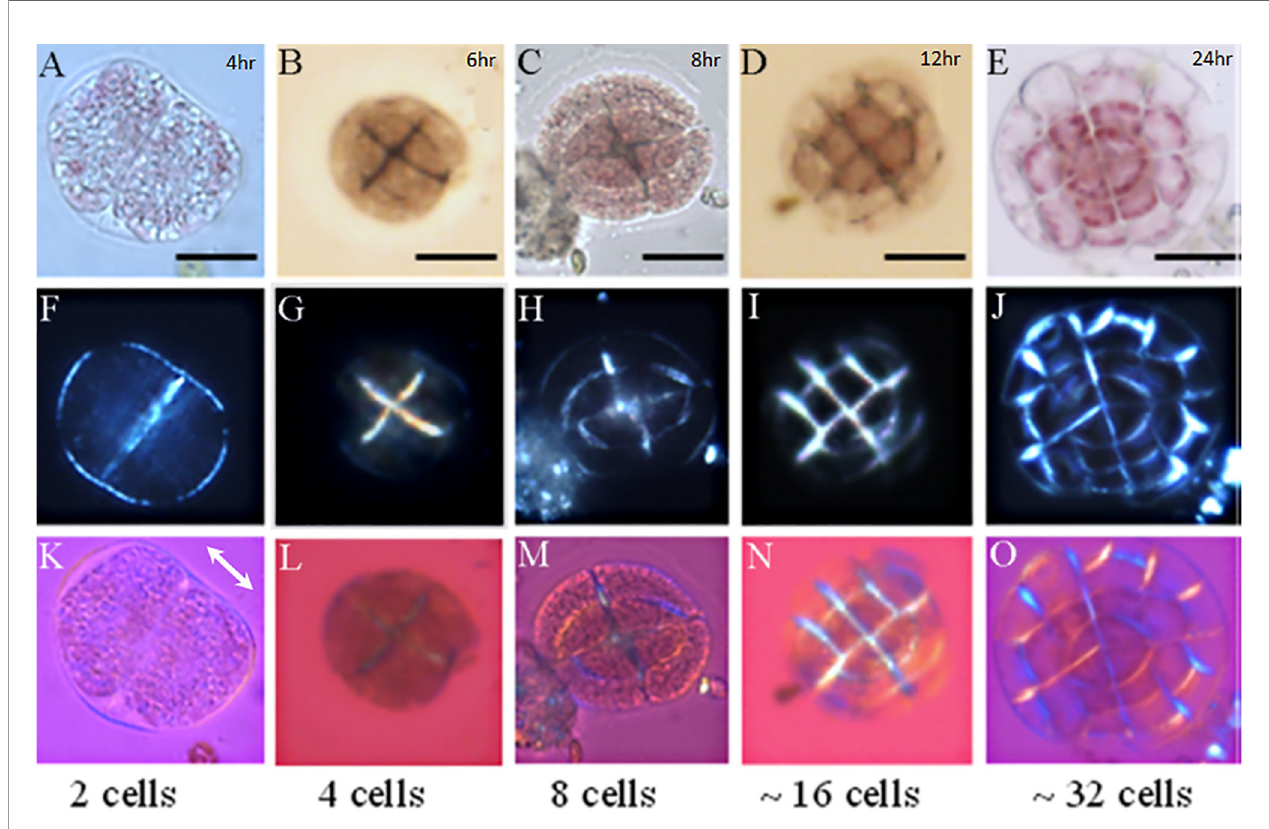
FIGURE 1 | Microscopic images of L. corallinae germinating spores in different development stages. 2, 4, 8, 16 and 32 germinating spores over the slides; Light microscopy (A – E) , PLM (F – J) and PLM with phase plate (K – O) . PLM showed the presence of polarized material inside the cell walls since the 2 cells spores ( Figure 1F ). PLM images with the utilization of a phase plate ( l = 551 nm) con fi rm the presence of calcite crystals with the c axes oriented perpendicular to the cell walls beginning from the 8 cell stage (K – O) . Scale bar: 1A – 1C = 10 µm; 1D – 1E = 20